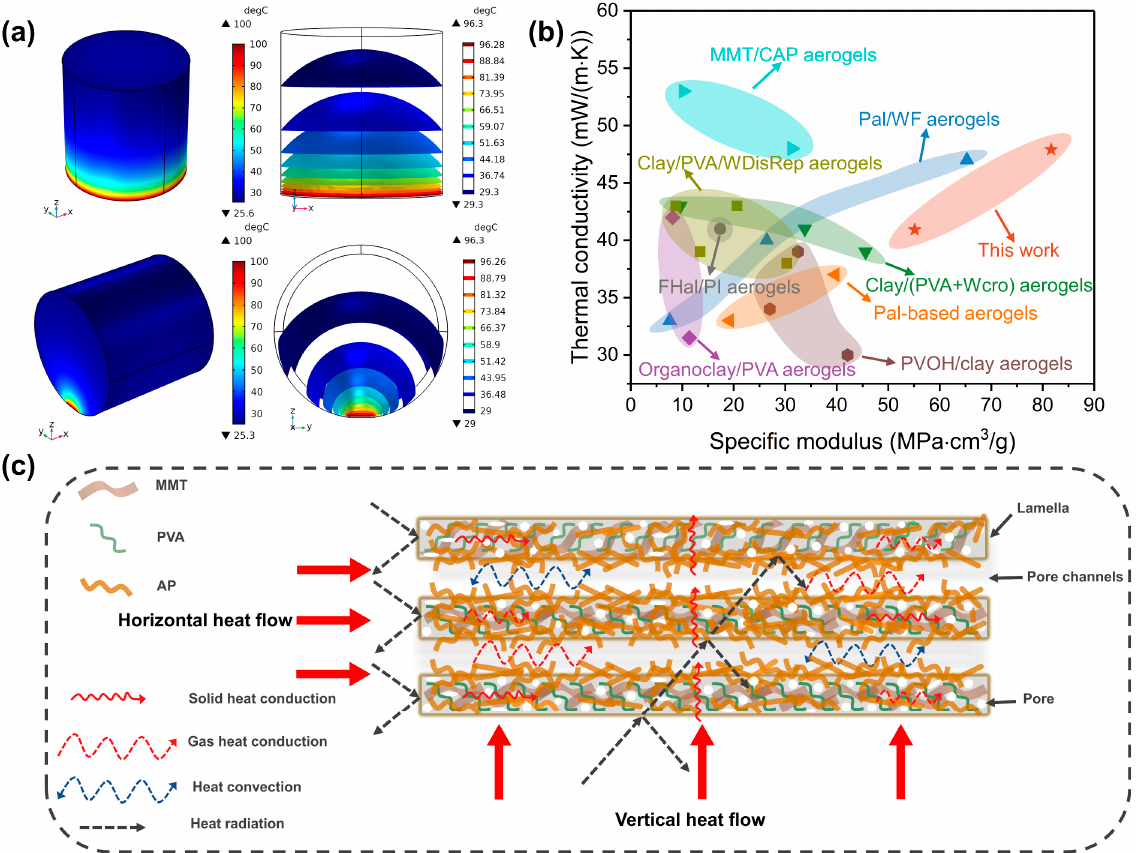
Figure 5. ( a ) The temperature profiles and isothermal surfaces (at 500 s) in the axial and radial directions. The heat transfer of a cylinder sample with a size of Φ 2 cm × 2 cm on a hot surface of 100 °C is simulated using the COMSOL Multiphysics software and all the modelling parameters are kept consistent with the infrared thermal imaging experiment. ( b ) The thermal conductivity versus specific modulus of the PVA-MMT-AP x and other clay aerogel composites [5,39,41,45–49]. ( c ) The schematic of the heat transfer of the aerogel composites in two different directions.